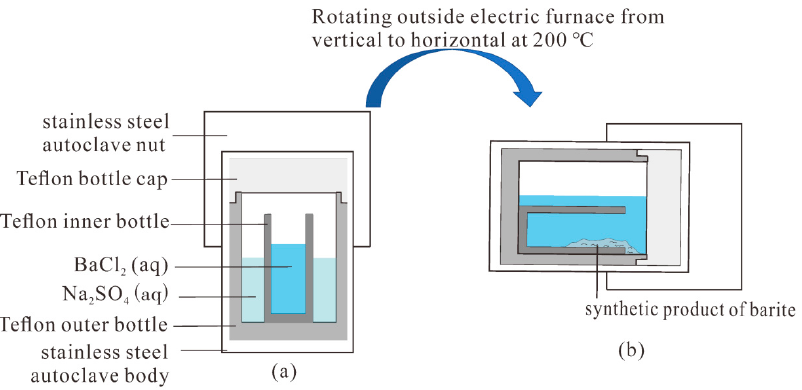
Figure 1. Simple diagram of synthetic equipment. ( a ) before mixing at 200 °C ( b ) after mixing at 200 °C. After quenching and cooling, the solution and products in the Teflon bottle were poured into the centrifugal tube and centrifuged to extract the precipitate. Then the pre- cipitate was washed three times alternately with deionized water and anhydrous ethanol.